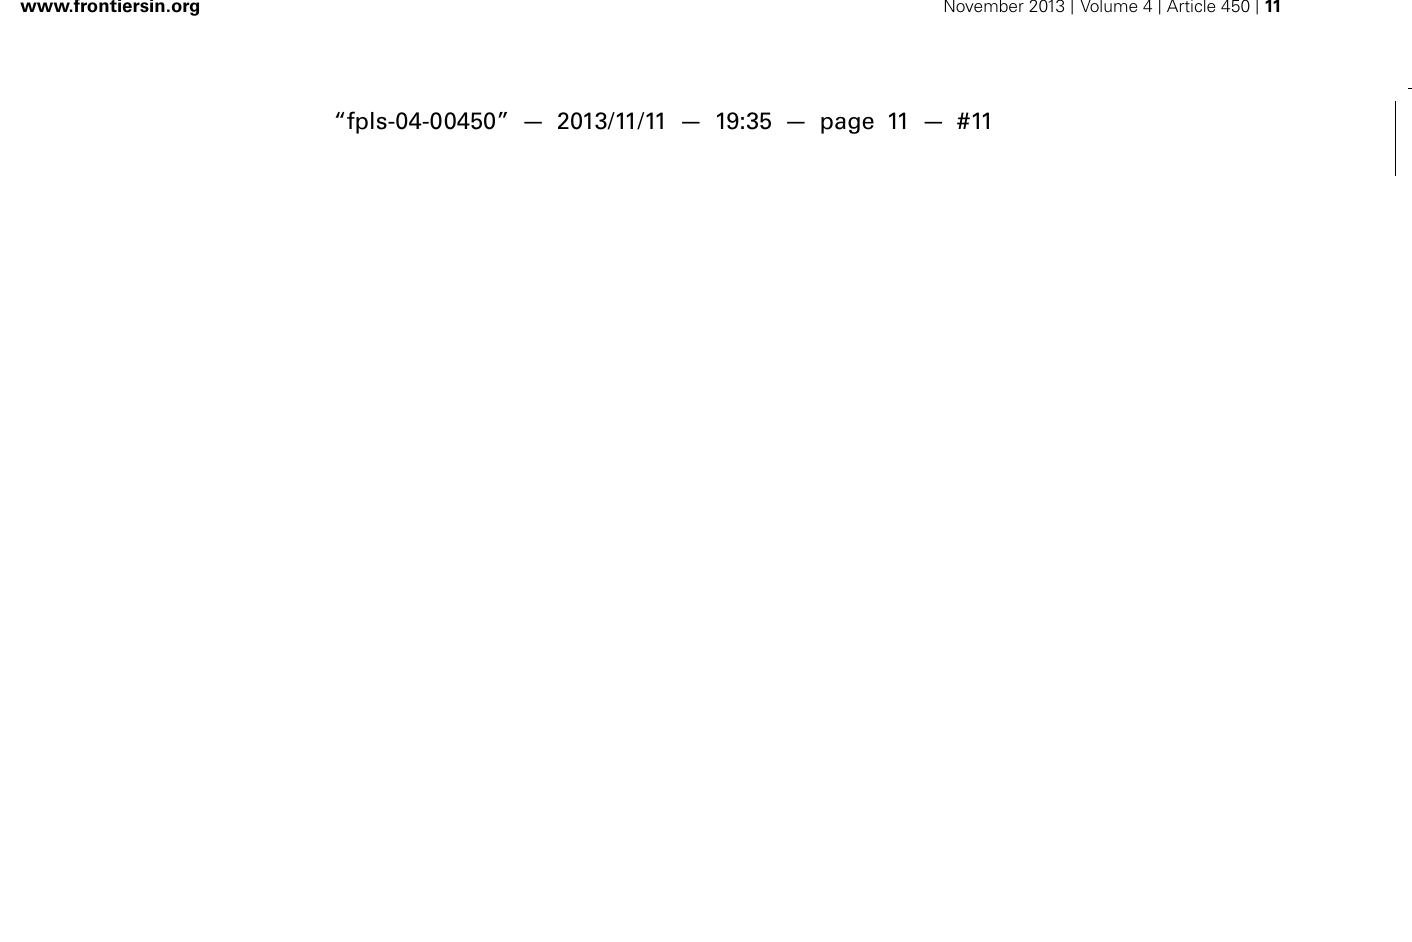
nitrosylation of GAPDH, and counteracted by several processes. For a detailed explanation, see text (Animal GAPDH: redox-dependent non-glycolytic (moonlighting) functions). GOSPEL, GAPDH’s competitor Siah1 protein enhances life; N-CoR, nuclear co-repressor; Siah1, seven in absentia homologue